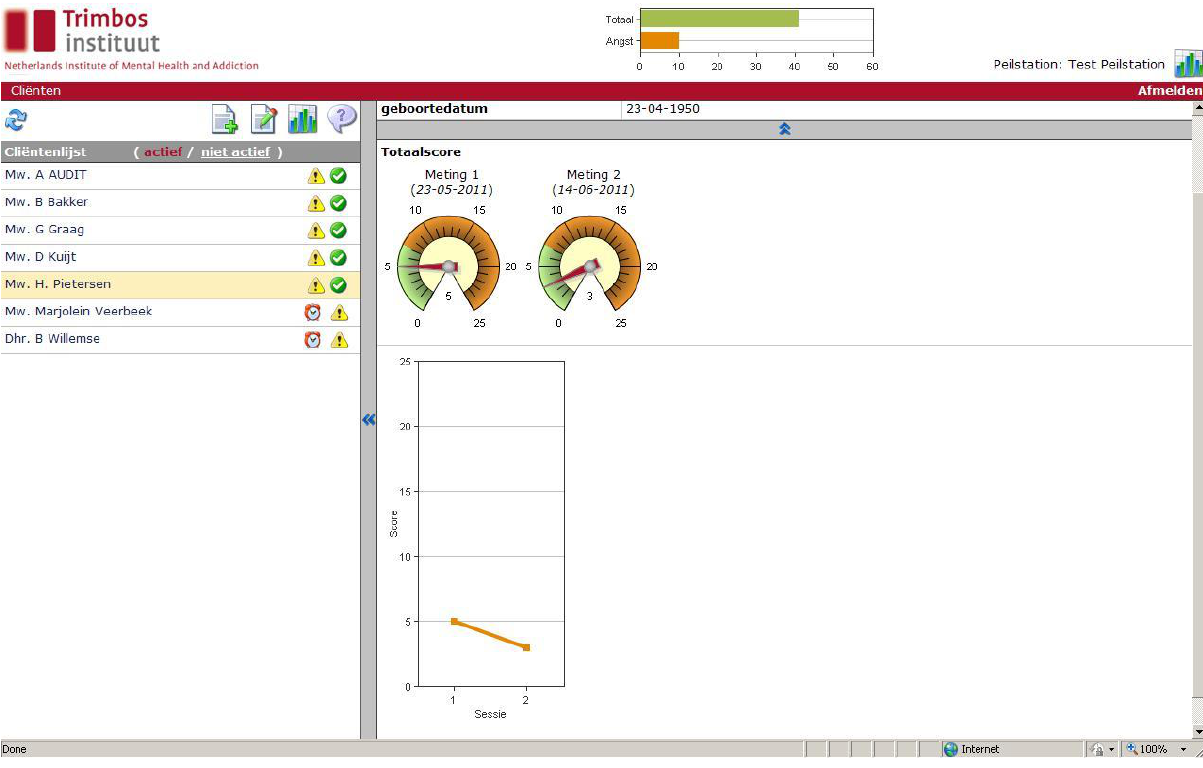
Figure 1. Example of the graphical feedback generated by the Web-based system to show clinicians the progress of their client during treatment. Clarification of Dutch language terms: Totaalscore = sum score (at a particular questionnaire); Meting 1 = sum score at intake; Meting 2 = sum score at the second moment in time; Score (y-axis) = sum score; Sessie (x-axis) = session (1 = intake, 2 = second moment in time). Clarification of symbols: exclamation mark = questionnaires have to be filled out for this particular client; check mark = the client has ended treatment; alarm clock = client has been monitored for 1 year and therefore monitoring can be